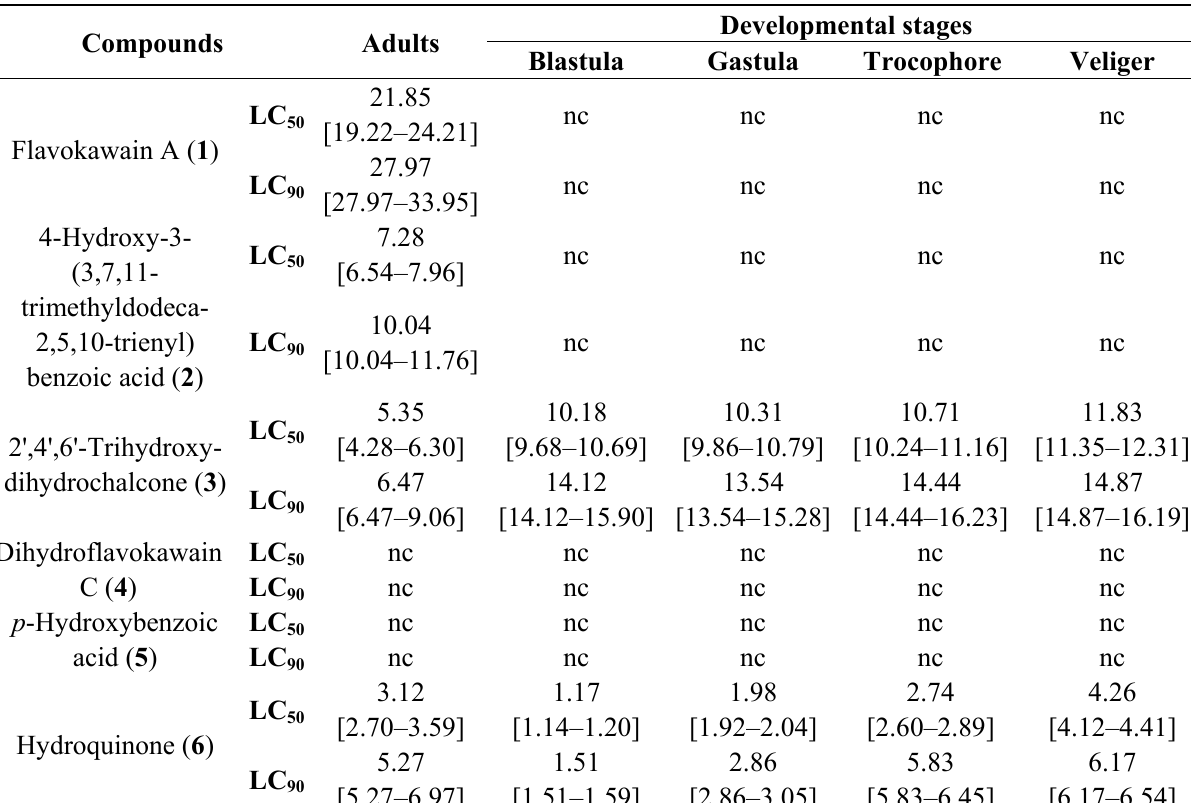
Table 2. LC and LC (µg/mL) for B. glabrata in different developmental stages exposed 50 90 to isolated